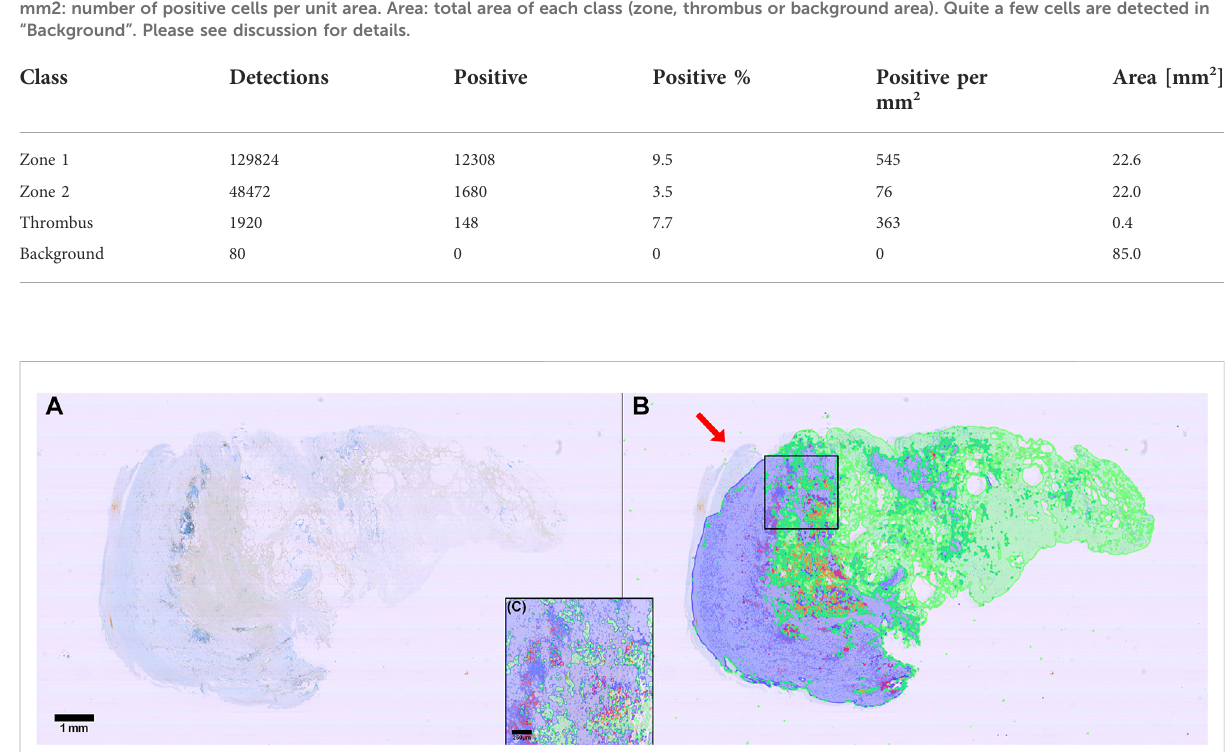
TABLE 4 CD8 positive cell detection for a patient sample. The detections are the total cell count for the indicated class. Detections: number of cells detected per zone class. Positive: number of CD8 positive cells. Positive%: percentage og all detected cells that are CD8 positive. Positive per